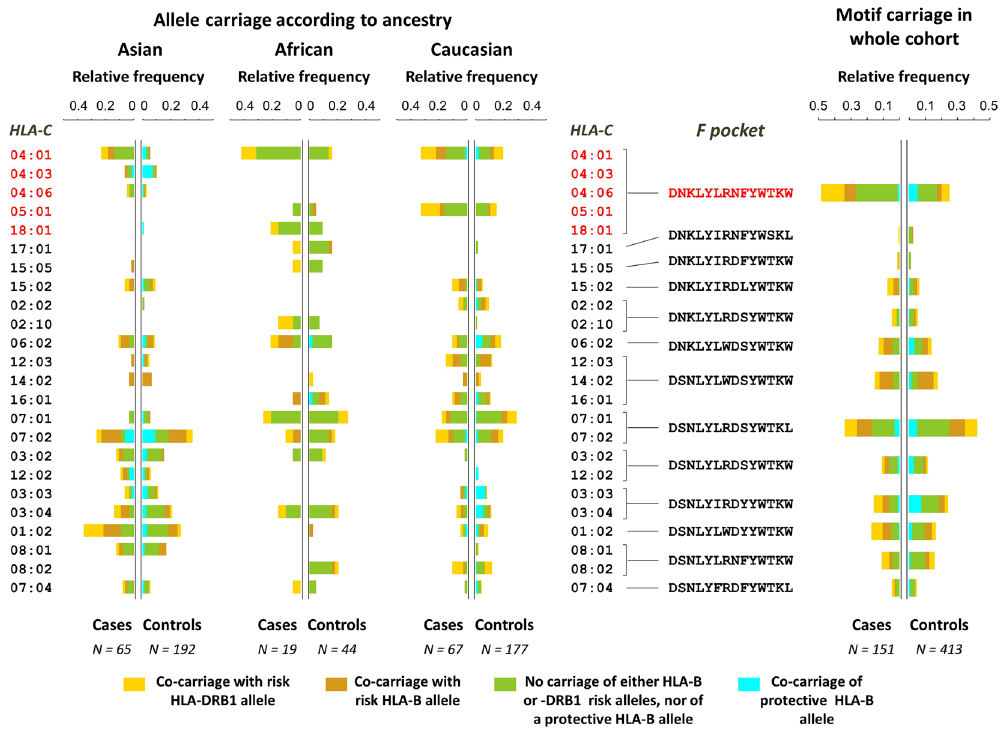
Figure 4. Relative frequency distributions for carriage of HLA-C alleles and characteristic F pocket motifs and co-carriage with other HLA risk or protective alleles. Results show the proportions of carriers amongst cases and controls for the HLA-C F pocket motifs prevalent in this cohort (N ≥ 5 carriers), and the corresponding relative frequency profiles for the alleles sharing each motif according to ancestral group. The primary risk cluster and characteristic motif are labelled in